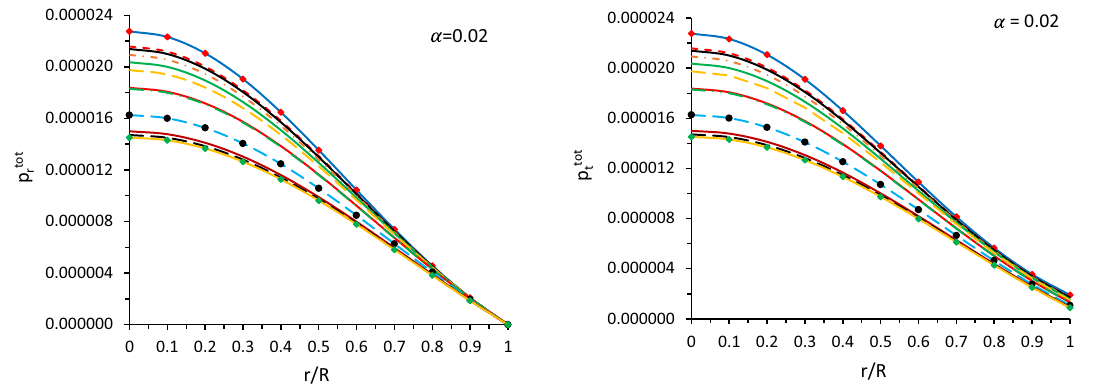
Fig. 5 The behavior of total radial pressure ( p tot r ) and total tangential pressure ( p tot t ) versus radial coordinate r / R by taking the numerical values of the constants a = 0 . 003, b = 0 . 0000053, β = 1 . 1, and γ = − 0 . 001